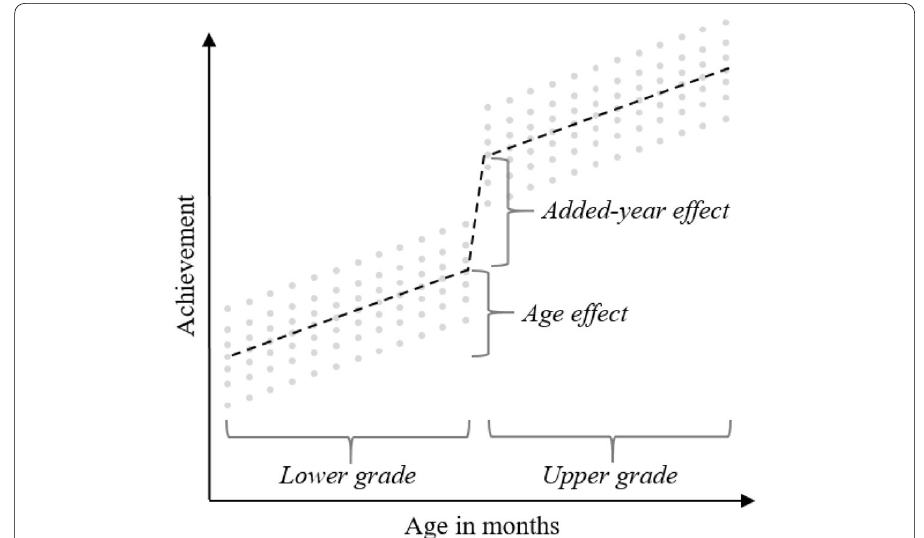
Fig. 1 Schematic illustration of the regression discontinuity approach. Figure displays the results of the regression (dashed line) of achievement scores (y-axis) on age in months (x-axis) and an added year of schooling in a sample of students (grey dots) from two adjacent grades. Within grades, the slope reflects the effect of age. The discontinuity in the regression reflects the effect of an added year of